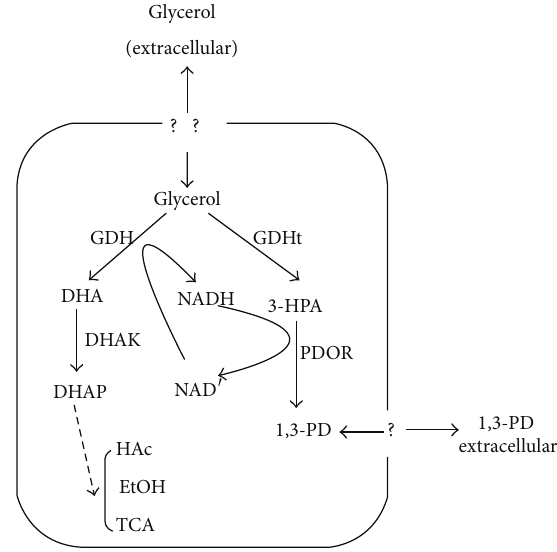
Figure 1: The metabolic pathway of glycerol converts into 1,3-PD by Klebsiella pneumoniae . Abbreviations: GDHt, glyc- erol dehydratase; 3-HPA, 3-hydroxypropionaldehyde; 1,3-PD, 1,3- propanediol; PDOR, 1,3-PD oxidoreductase; GDH, glycerol dehy- drogenase; DHA, dihydroxyacetone; DHAK, dihydroxyacetone kinase;DHAP,dihydroxyacetonephosphate;HAc,aceticacid;EtOH, ethanol; TCA, TCA